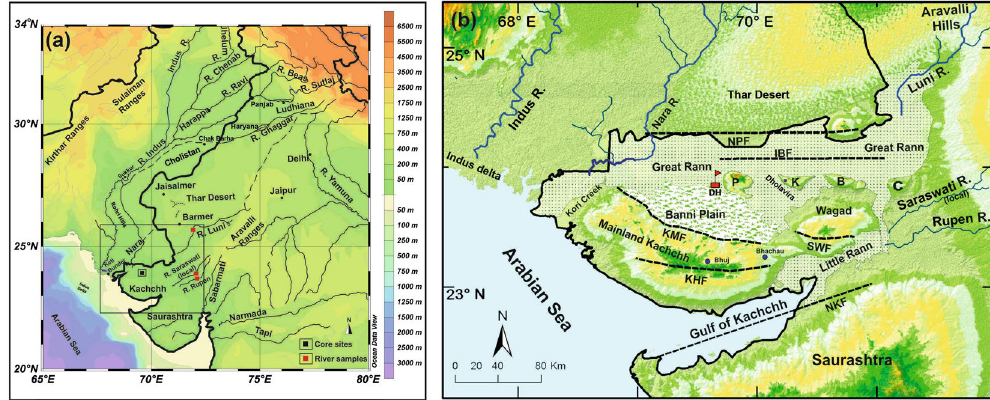
Figure 1. ( a ) Regional drainage pattern for the western continental margin of the Indian plate. Dotted lines are the paleochannels of the Vedic Saraswati River after Ghose et al . 11 and Kar and Ghose 48 . The box represents the area shown in b. Location of the Dhordo core site and river sediment samples analyzed are also shown. ( b ) Geomorphic setting of the Great Rann of Kachchh (GRK) basin with surrounding hinterland and core locations. NPF- Nagar Parkar Fault, IBF- Island Belt Fault, KMF- Kachchh mainland Fault, KHF- Katrol hill Fault, NKF- North Kathiawar Fault, SWF- South Wagad Fault, P- Pachham Island, K-Khadir Island, B- Bela Island and C- Chorar Island. Core location: DH- Dhordo core raised from central GRK basin. Maps were prepared using a licensed copy of Ocean Data 49 View